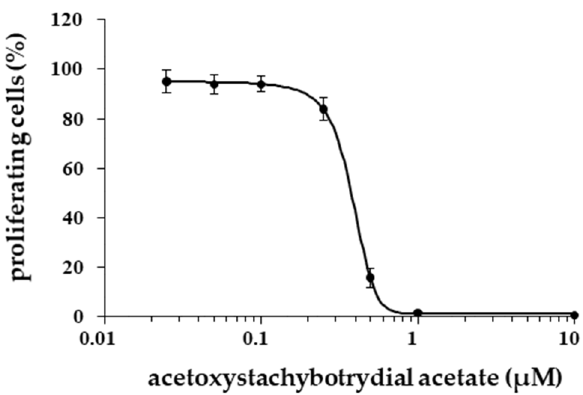
Figure 8. Dose-dependent inhibition of MCF7 NucLight green cell proliferation by acetoxystachy- botrydial acetate using EdU assay. The EC 50 is 0.39 ± 0.02 µM, which was determined in three independent replications. Mean values with standard deviations are given.